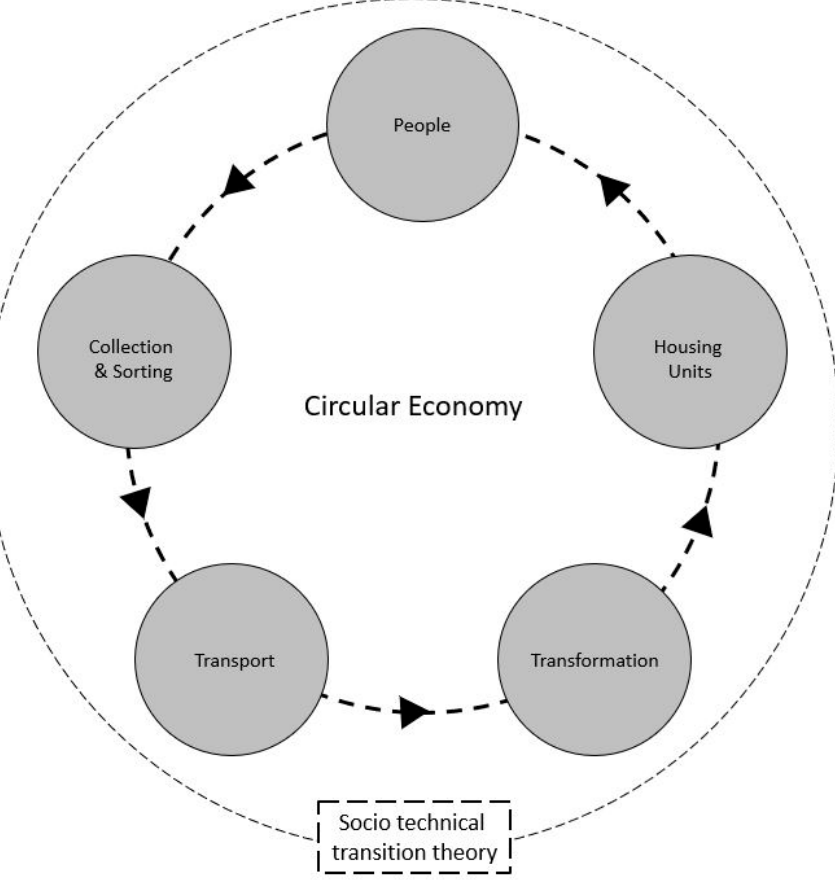
Figure 5. Proposed model for conversion of waste into housing units.